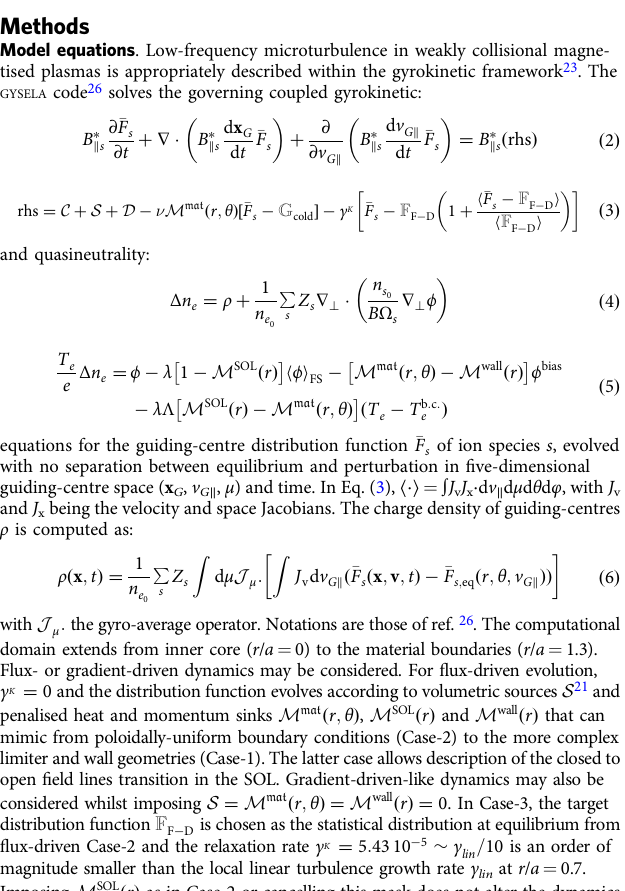
temperature at mid radius whilst the target density n w is chosen so as to ensure particle